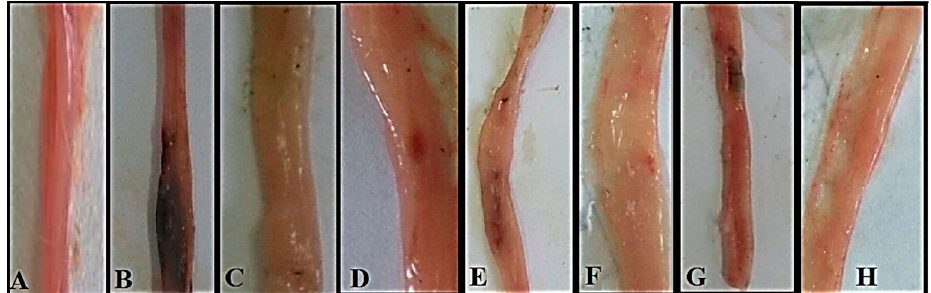
Figure 2. Photograph of Macroscopic features of rat colon shows ( A ) Negative control: normal colon tissue with no apparent damage. ( B ) Positive control: considerable inflammation, ulceration, wall thickening, necrosis and gangrenous changes in colon tissue ( C ) Dexamethasone standard: apparent normal with no damage in colon tissue. ( D ) Nano-Ag: mild inflammatory changes, no evidence of ulceration showing significant improvement ( E ) ASBE: moderate inflammatory changes & signs of ulceration showing little improvement ( F ) ASBE plus nano-Ag: mild inflammatory changes, no evidence of ulceration showing significant improvement ( G ) ASB nano-extract: moderate edematous changes, moderate signs of ulceration showing little improvement ( H ) ASB nano extract plus nano-Ag: apparent normal no evidence of damage in colon tissue.